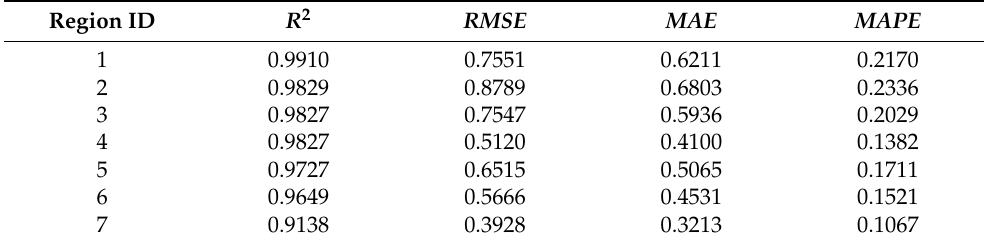
Table 4. Comparison of R 2 , RMSE , MAE and MAPE for seven study areas (average for five runs). Region